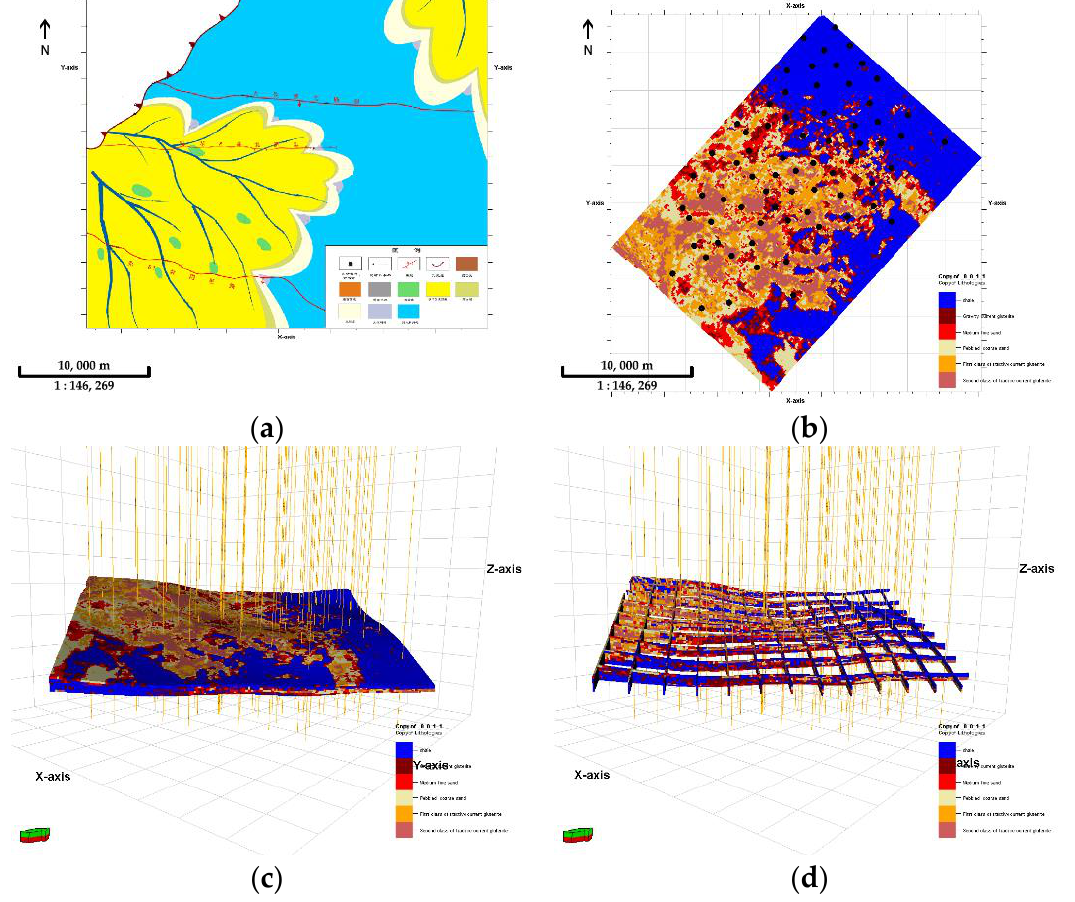
Figure 5. Lithofacies model of the X area of Karamay, Xinjiang, China: ( a ) sedimentary facies map of the second member of the Urho Formation; ( b ) lithofacies model of A 1 ; ( c ) 3D lithofacies model of the X area in Karamay, Xinjiang, China; and ( d ) 3D perspective lithofacies model of the X area in Karamay, Xinjiang, China.